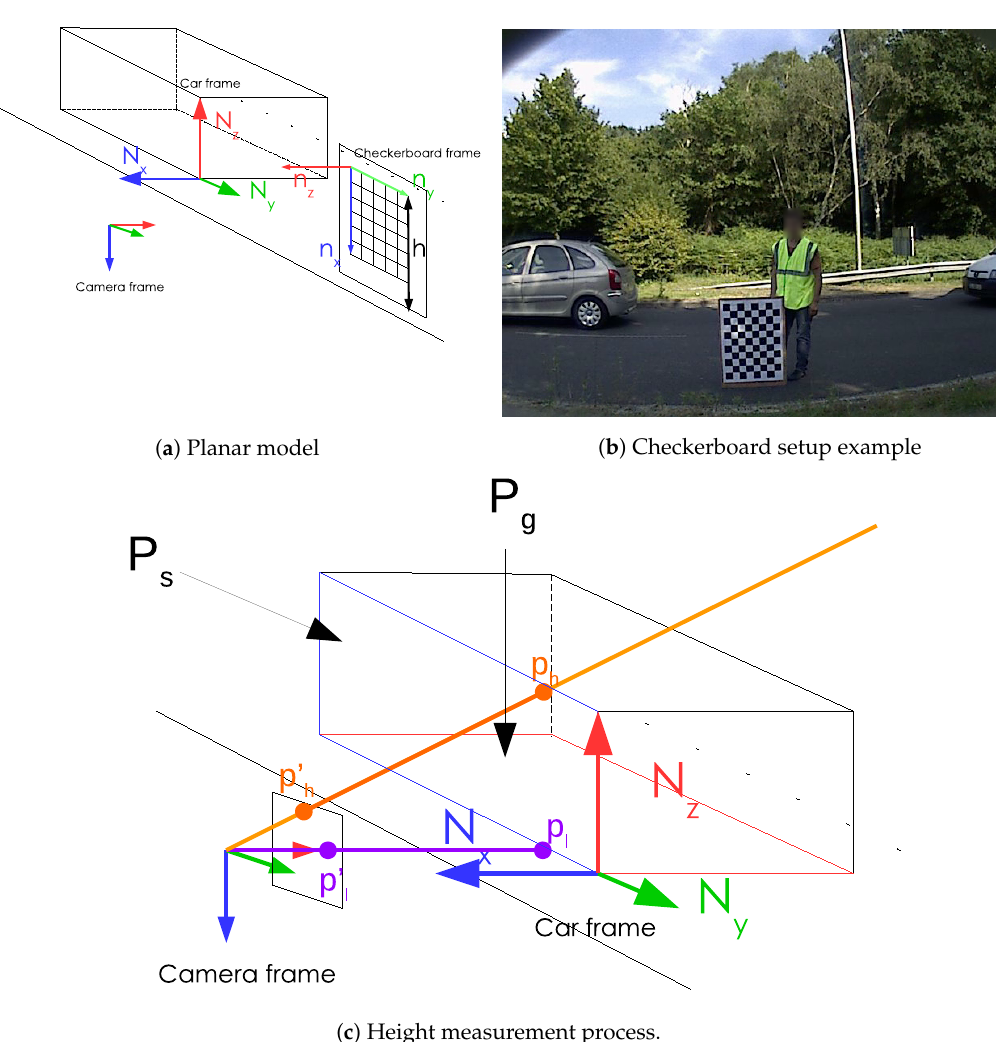
Figure 2. Extrinsic calibration and height